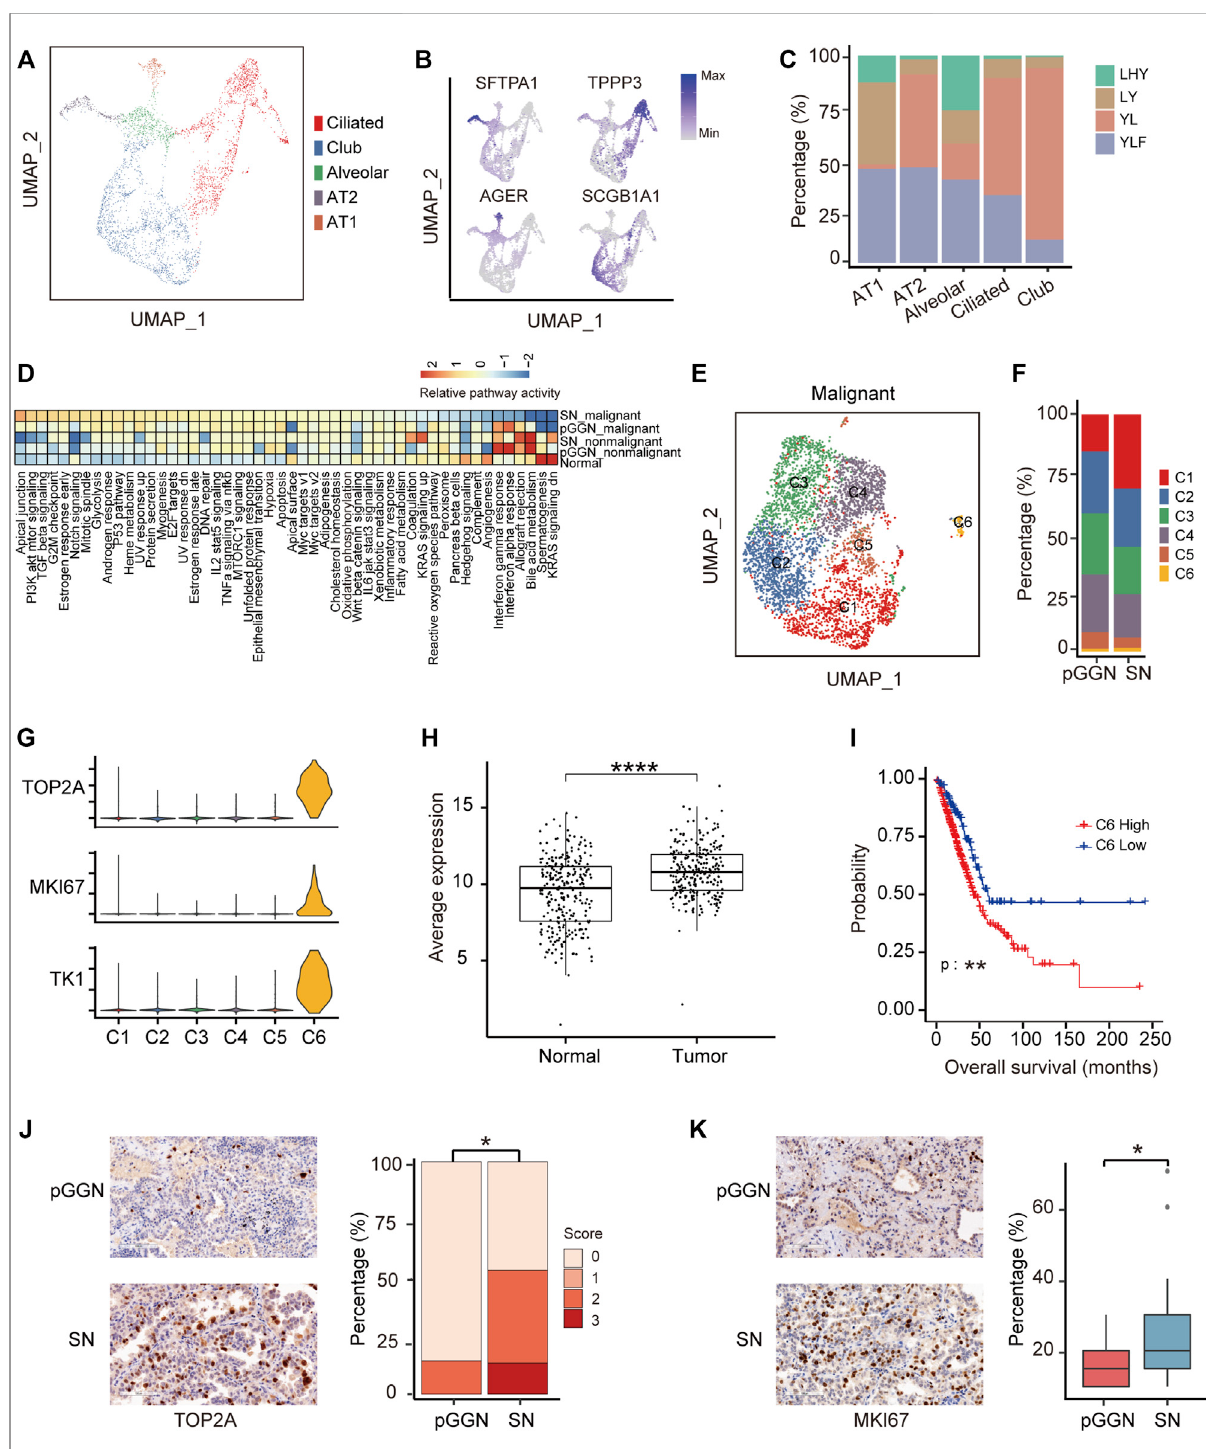
FIGURE 2 Proliferation ability of special epithelial cells increases during the progression of LUAD. (A) UMAP plot of epithelial cells from 4 normal adjacent tissues, coloredby5cellsubtypes. (B) UMAP plotofcanonical celltypemarkers,coloredbygeneexpression.Fourhighlyexpressedgeneswereused to de fi ne 5 cell types, of which one cell type is a mixture. (C) The proportion of normal samples among each cell type, colored by patient origins. (D) The enrichmentofhallmarkpathwaysbyGSVAanalysis amongnormalepithelial cells, nonmalignantcells,and malignantcells.The scoreswere sortedbyrelativepathwayactivity. (E) UMAPplotofepithelialmalignantcells,coloredby6cellsubsets.Epithelialcellsfromtumortissuesweredivided into malignant cells and nonmalignant cells by inferCNV. (F) The proportion of cell types among each tissue origin, colored by cell subtypes. (G) The